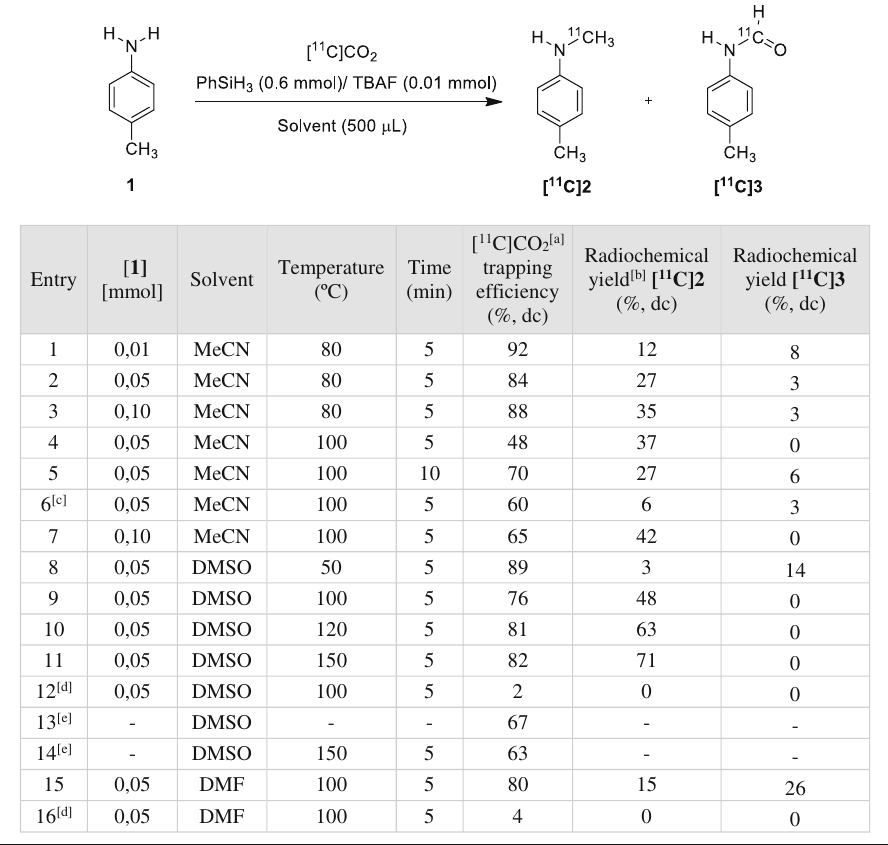
Table 1 Direct 11 C-methylation of 1 with [ 11 C]CO